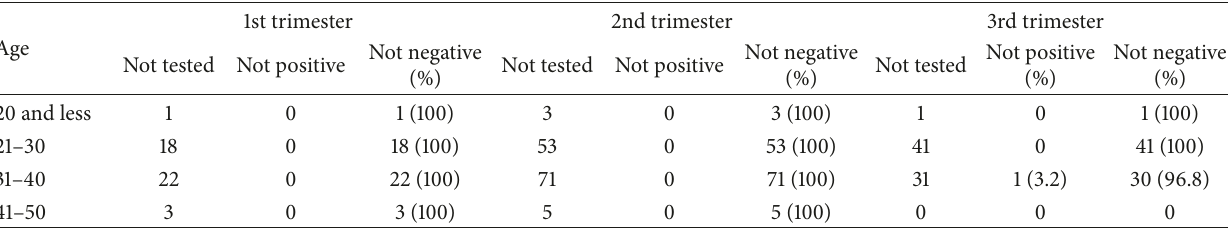
Table 2: HEV acute infection among the pregnant